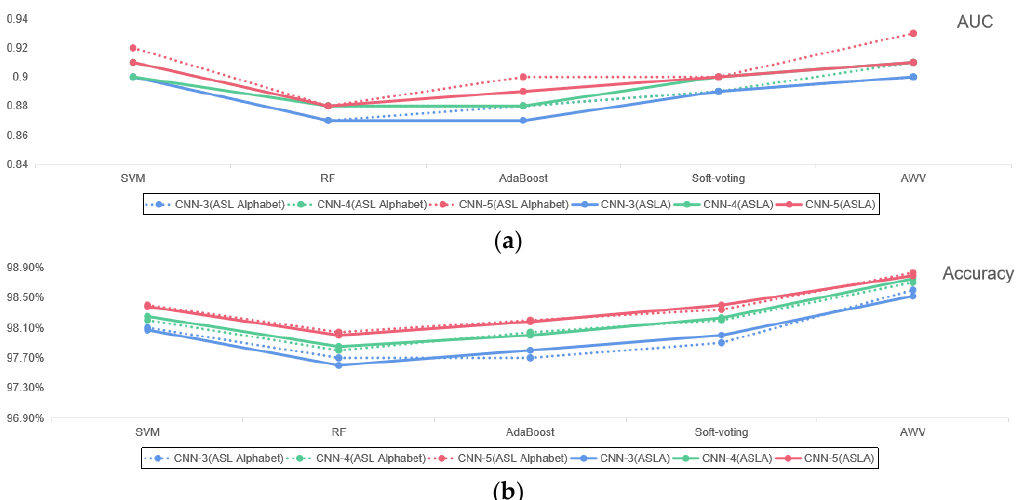
Figure 6. The performance scores for three types of multiple deep CNNs in the ARS-MA model: ( a ) AUC and ( b ) Accuracy. Table 9. Accuracy and time/image by λ .